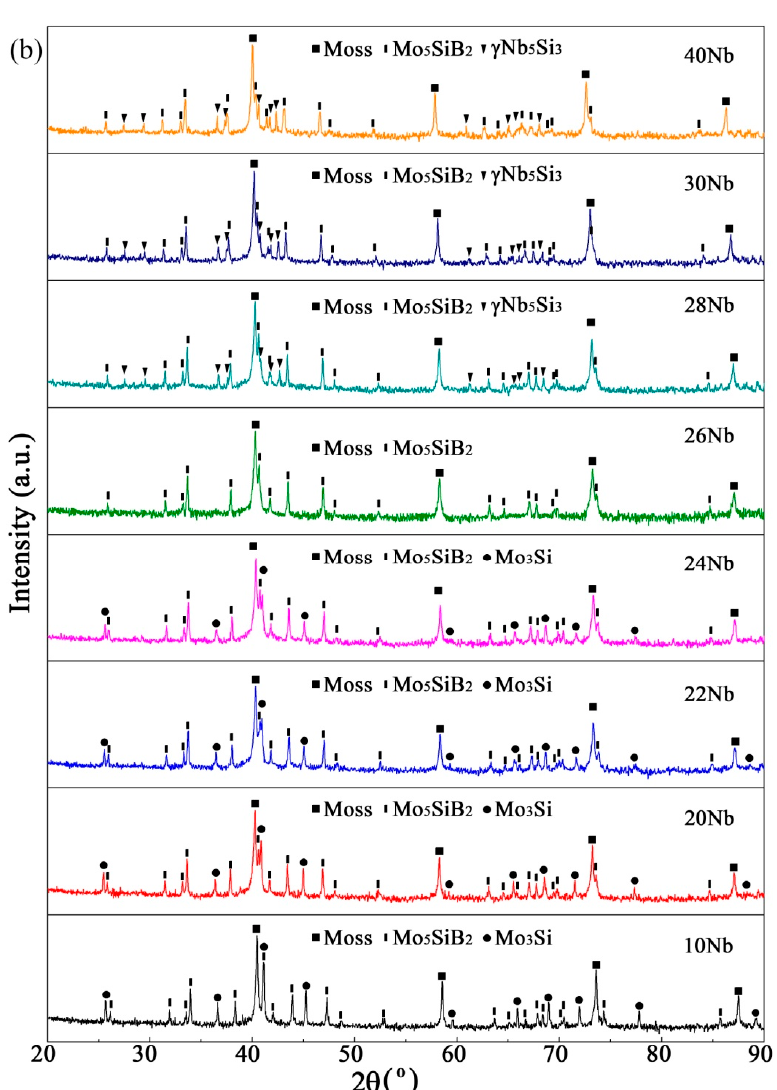
Figure 9. XRD spectra (logarithmic Y-axes) of samples ( a ) S-xNb / 10h and ( b ) S-xNb / 50h (x = 10, 20, 22, 24, 26, 28, 30, and 40).